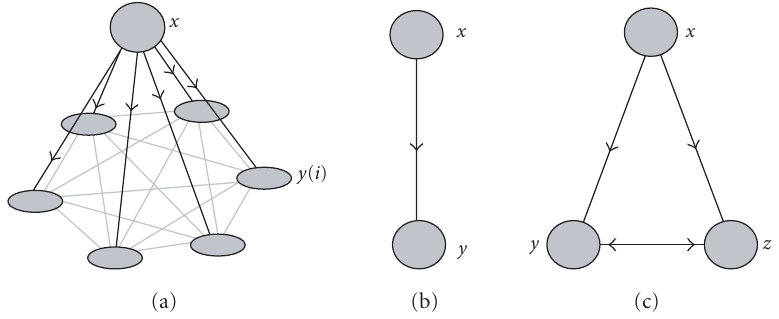
Figure 1.1. Schematic illustration of a network with global coupling, elements of which are under common pacemaker (a), two unidirectionally coupled maps (b), and two coupled maps under com- mon pacemaker